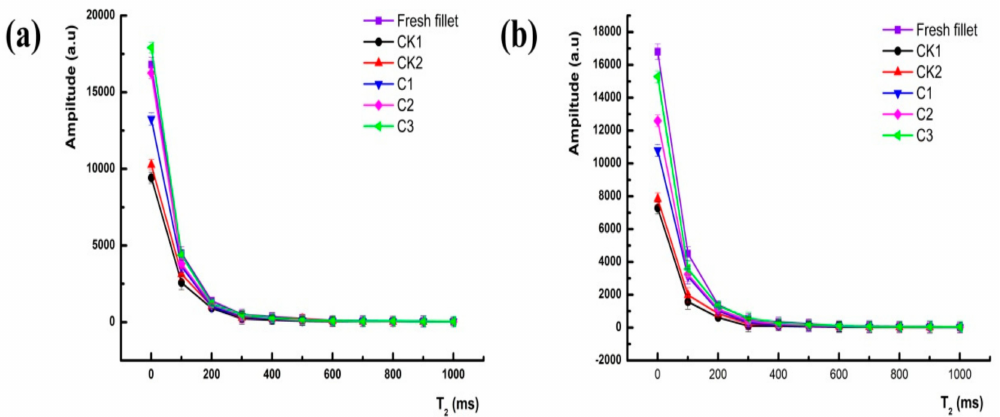
Figure 2. Changes in CPMG echoes of samples under different treatments on the 12th ( a ) and 24th day of the refrigerated period (CK1: distilled water + air packing; CK2: edible coating + air packing; C1: edible coating + MAP (60% CO 2 /40% N 2 ); C2: edible coating + MAP (65% CO 2 /35% N 2 ); C3: edible coating + MAP (70% CO 2 /30% N 2